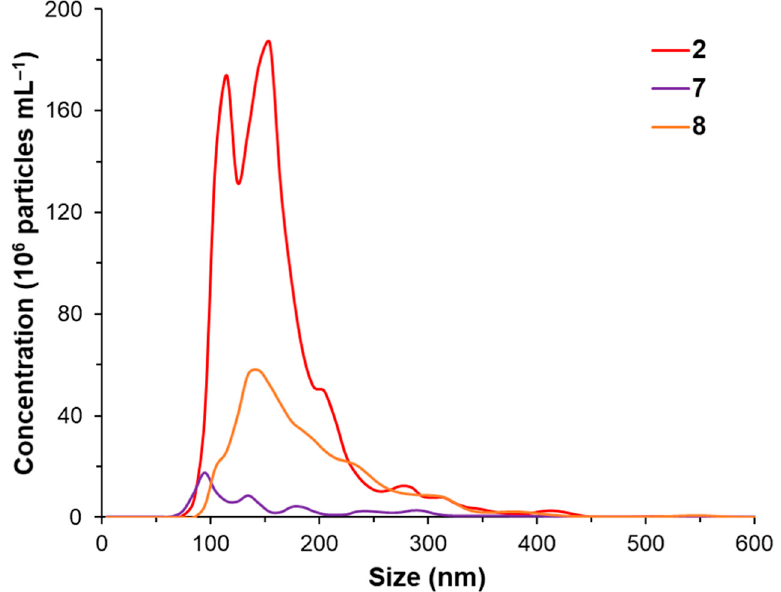
Figure 7. Size distribution of 2 , 7 , and 8 in PBS/DMSO mixtures, from nanoparticle tracking analysis (NTA). [ 2 ] = [ 7 ] = [ 8 ] = 20 μ M. The dilution factor is the same for all samples. Content of DMSO was 1 vol % in all samples. Average data from five independent captures are shown. T = 25 °C. Particle concentrations and size values, with relative standard deviations, are given in Table S2 (Supplementary Materials).